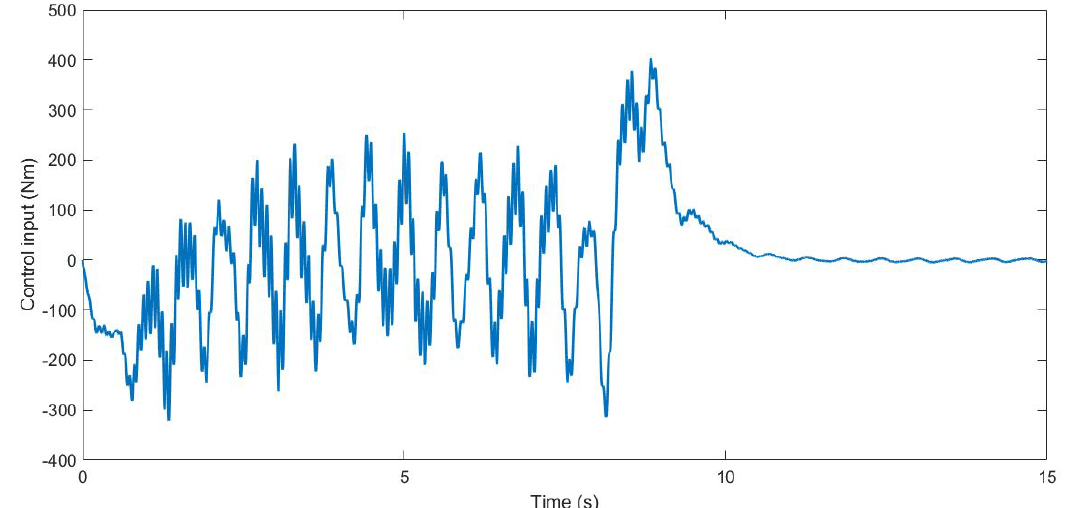
Figure 5. Control input u for Test 1.